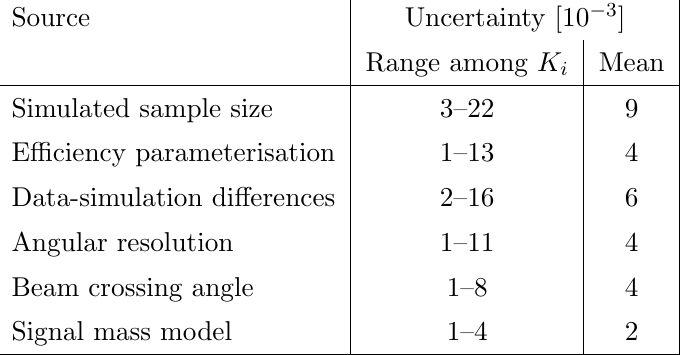
forward-backward asymmetries of the decay are determined to